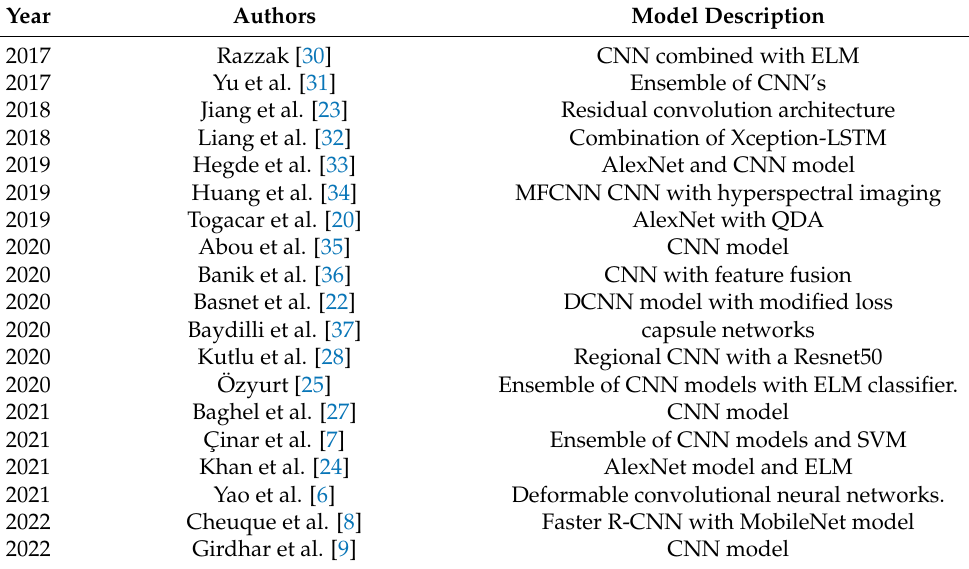
Table 1. Summary of WBC classification methods in chronological